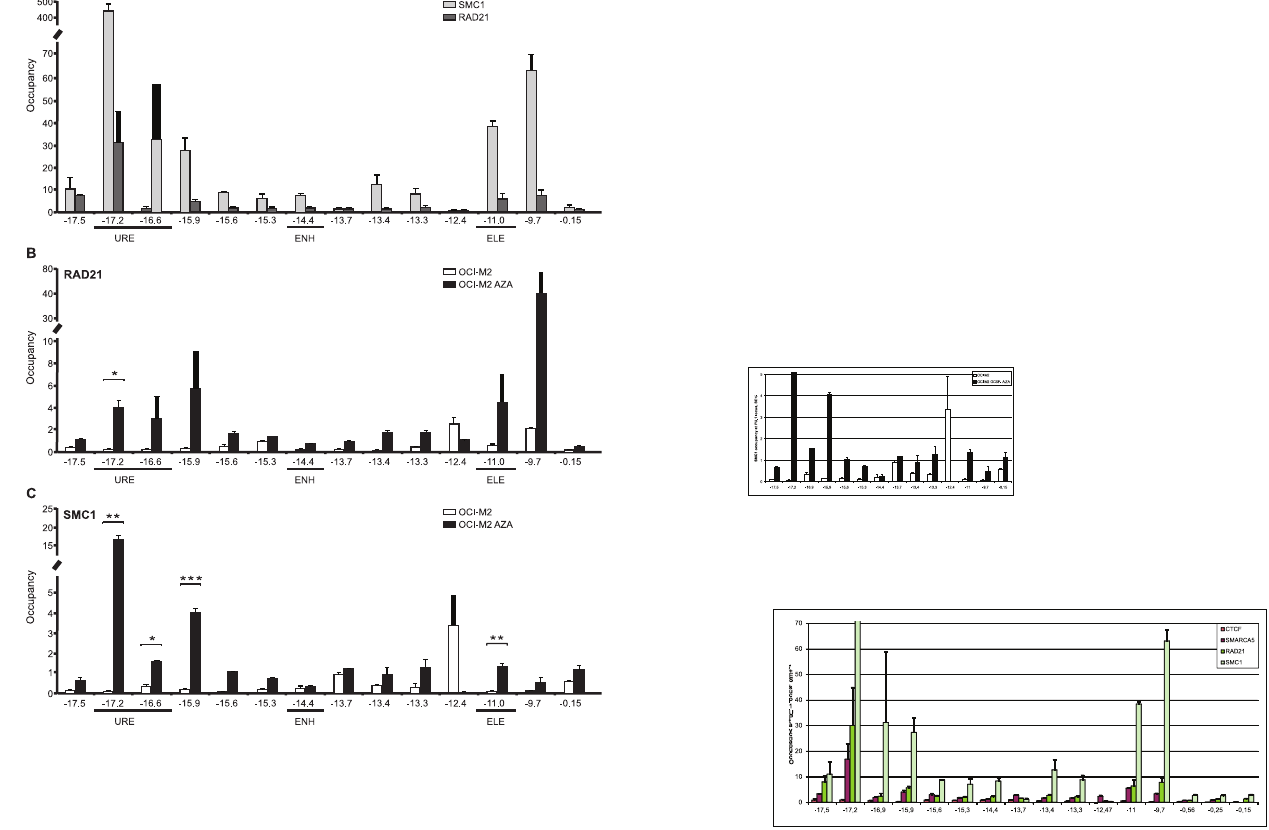
Figure 5. Binding of Cohesin complex members to SPI1 locus. A: ChIP of RAD21 and SMC1 in mixed myeloid cells. B: ChIP of RAD21 and C: SMC1 in OCI-M2 without (OCI-M2) or with AZA (OCI-M2 AZA) treatment. Y-axis: ChIP enrichment. X-axis: amplicons (distance relative to SPI1 TSS). URE, Upstream Regulatory Element of SPI1 gene; ENH, enhancer; ELE, element. Error bars: the standard errors (SE). Asterisks: p-values (t-test, 0.05–0.005).